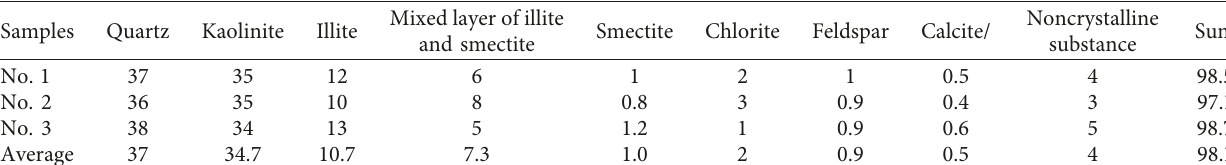
Figure 1: Preparation of experimental samples: (a) 20–15mm; (b) 15–10 mm; (c) 10–5 mm. Table 1: Material compositions of the gangues in the coal mine (%).